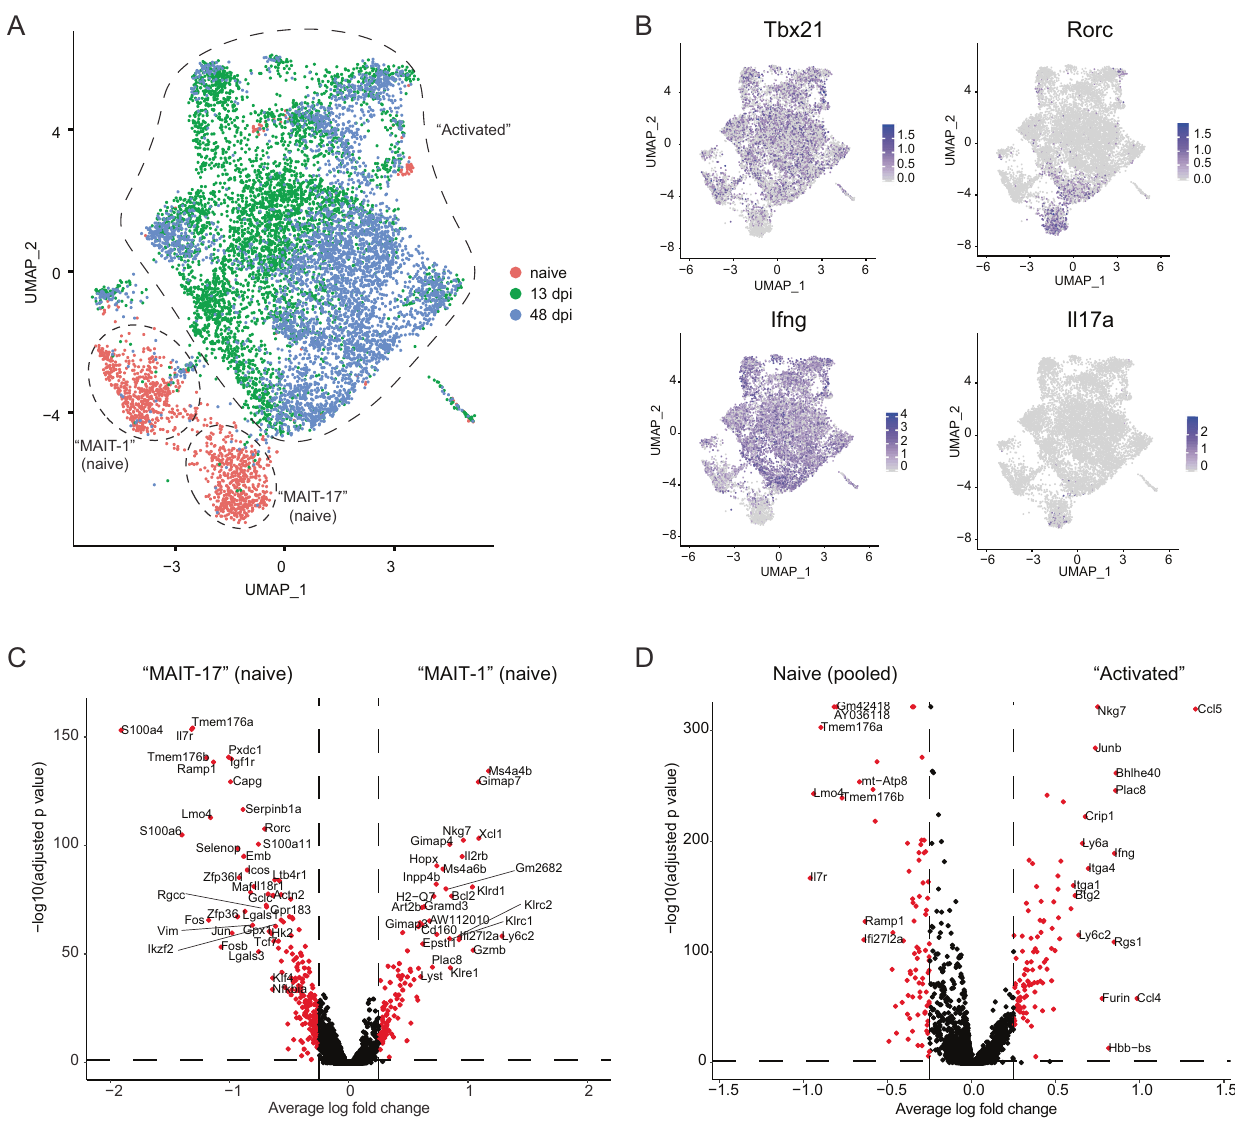
Fig. 5 Droplet-based scRNA-seq analysis of liver MAIT cells before and upon F. tularensis LVS infection. A UMAP representation of post-QC liver MAIT cell transcriptomes from naive mice ( n = 17) and mice at days 13 ( n = 2) and 48 ( n = 4) post infection, calculated using principal components (PC) 1 – 30. B UMAP representation of Tbx21 , Rorc , Ifng , and Il17a expression. C , D Volcano plots of differential gene expression calculated based on unsupervised clustering (Supplementary Fig. 7B), average log fold changes below − 0.25 or above 0.25 are highlighted in red, and gene names were highlighted when the average log fold change was below − 0.6 or above 0.6. C Volcano plots of differential gene expression analysis between MAIT-1 (cluster 5) and MAIT-17 (cluster 7) cells from naive mice. D Volcano plots of differential gene expression analysis between MAIT cells prior to (clusters 5 and 7) and post infection (clusters 0, 1, 2, 3, 4, 6, 8, 9, 10, 11, and 13). Cluster numbering derived from Supplementary Fig.